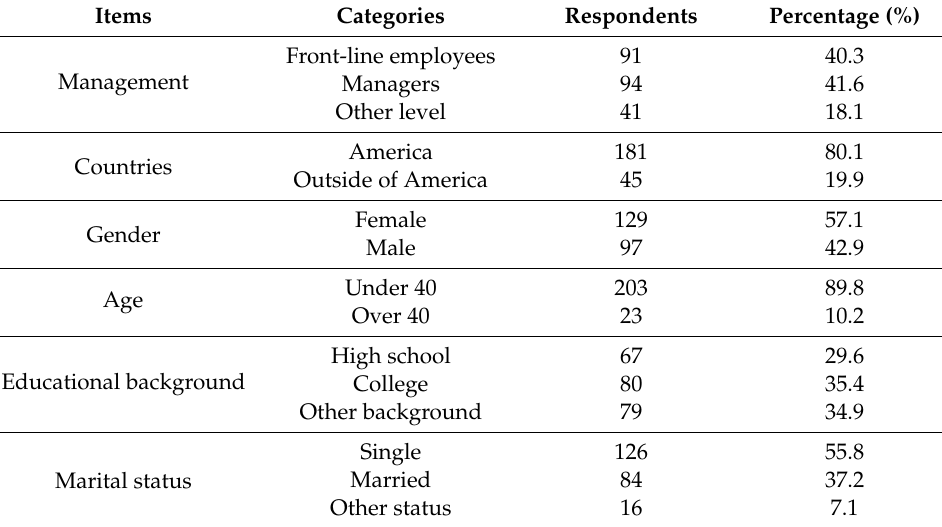
Table 1. Sample distribution of Study 1.